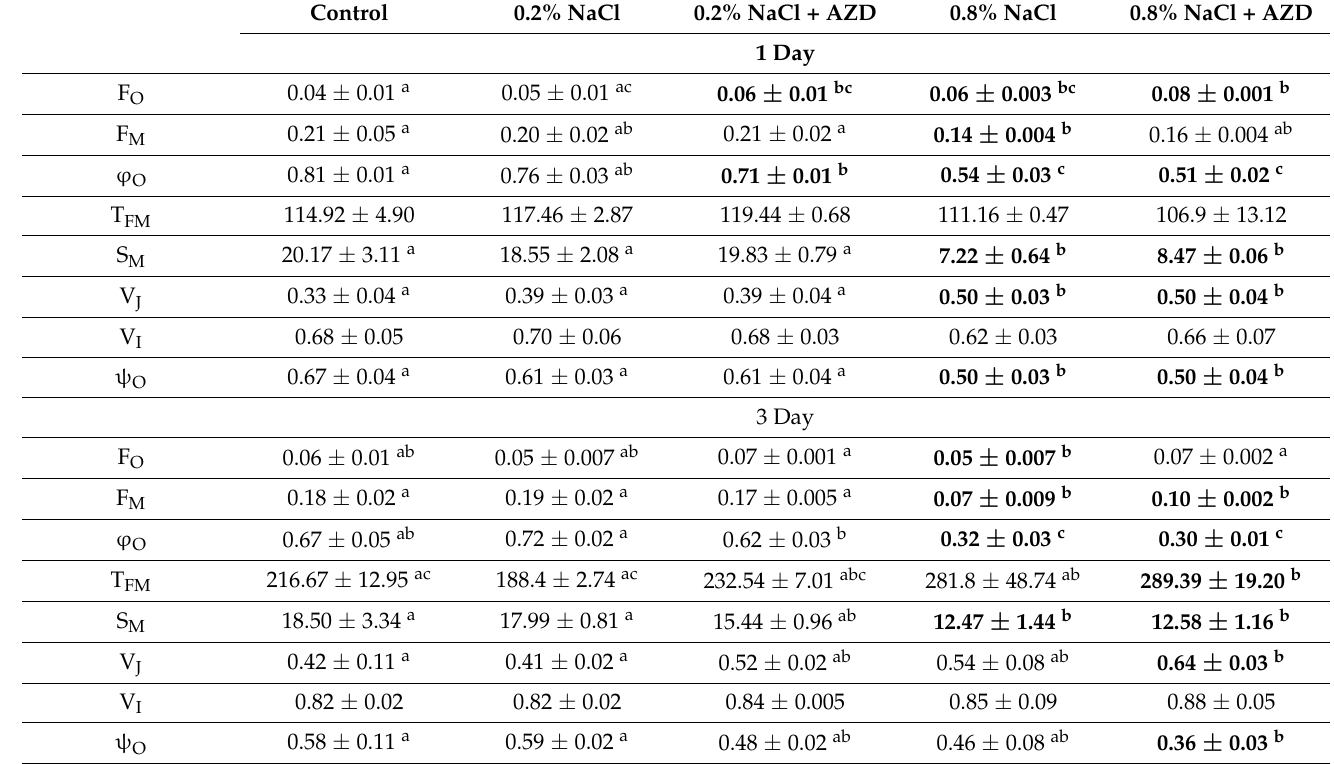
Table 1. Photosynthetic performance (JIP-tests parameters) in cells of Haematococcus lacustris on days 1 and 3 of salinity treatment. F O (relative units, r. u.)–minimal fluorescence in the dark-adapted state at open PSII reaction centres; F M (r. u.)–maximal fluorescence in the dark-adapted state at closed PSII reaction centres; ϕ O– maximal quantum yield of PSII in the dark-adapted state, similar to F V /F M ; T FM (ms)–time to reach maximal fluorescence F M which characterizes the rate of energy transfer from PSII reaction centres to the PQ pool; S M (ms)–normalized area above the OJIP curve after double normalization (F O = 0, F M = 1), which is a proxy of the number of electron carriers per electron transport chain; V J = (F J − F O )/(F M –F O )–relative variable fluorescense at step J (2 ms) which reflects the proportion of closed PSII reaction centres; V I = (F I − F O )/(F M − F O )–relative variable fluorescense at step I (30 ms) which reflects the intermediate stationary level of reduction of PQ pool and the electron acceptors beyond PQ; ψ O = (1 − V J )–probability of electron transport beyond Q A reflecting the level of oxidation of electron transport chain. Mean values ± SD are shown. Different letters indicate significant differences according to one-way ANOVA and post hoc Tukey test at p < 0.05 or less. Bold letters indicate significant differences relative to control cells. Control 0.2%